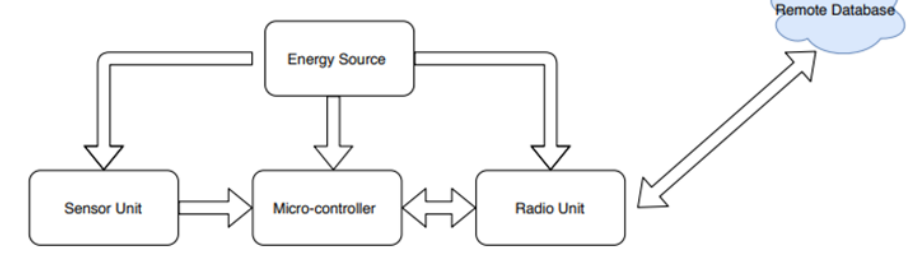
Figure 10. Sensor Node block diagram.